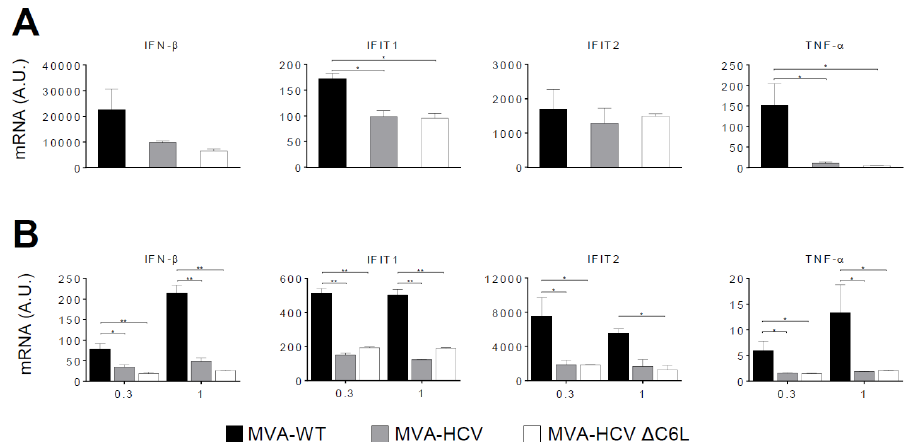
Figure 2. Innate immune responses induced by MVA-HCV and MVA-HCV ∆ C6L in human macrophages and monocyte-derived dendritic cells (moDCs). Human THP-1 (human